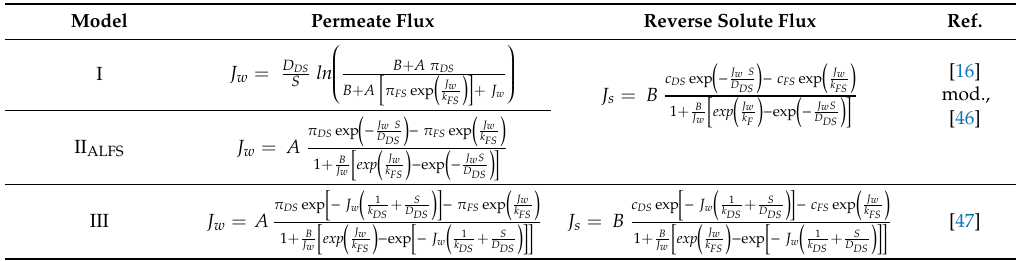
Table 2. Model equations for permeate and reverse solute flux using an ALFS membrane orientation. Model